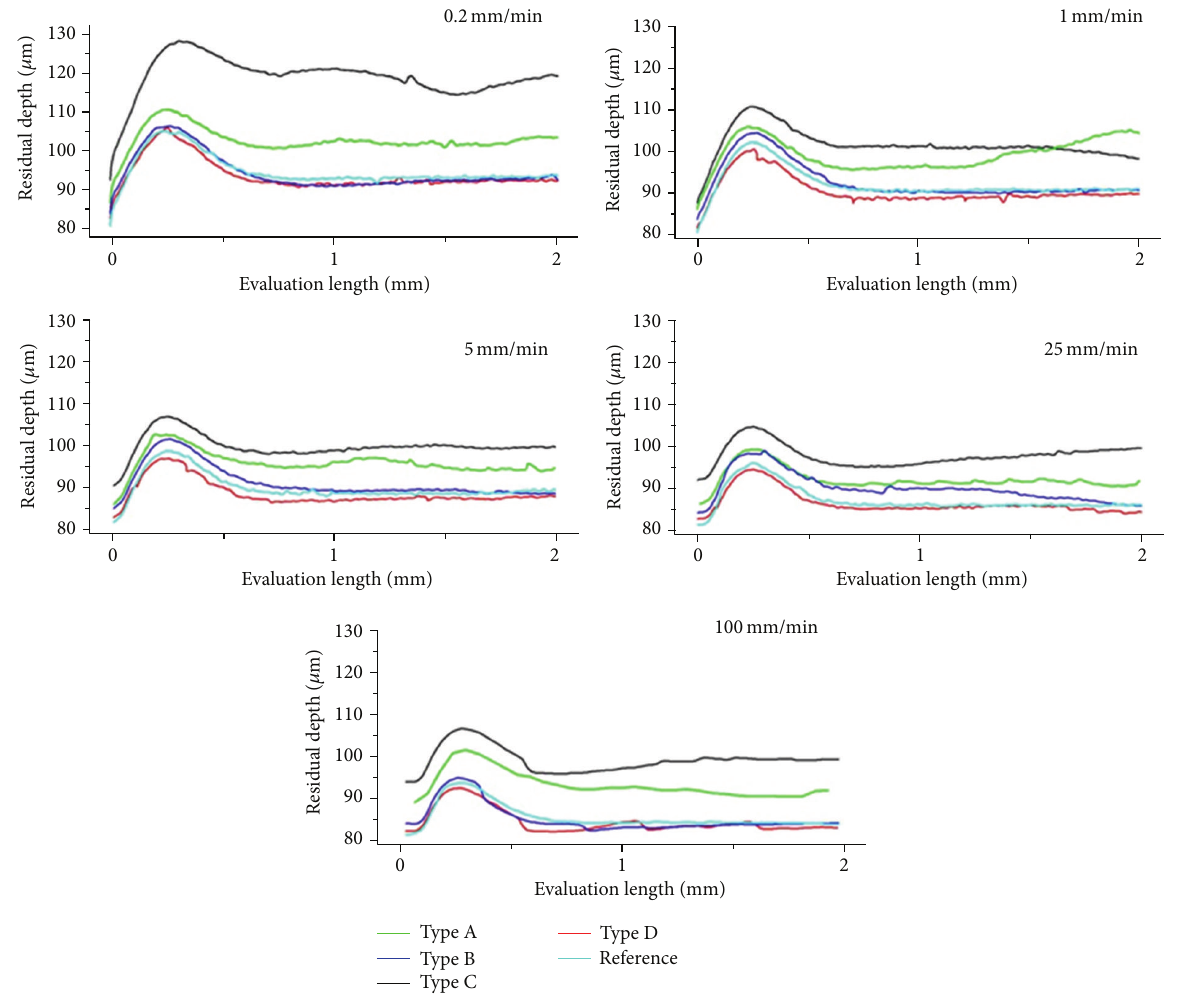
Figure 8: Residual depth 𝑅 𝑑 in scratch tests at constant load and different sliding